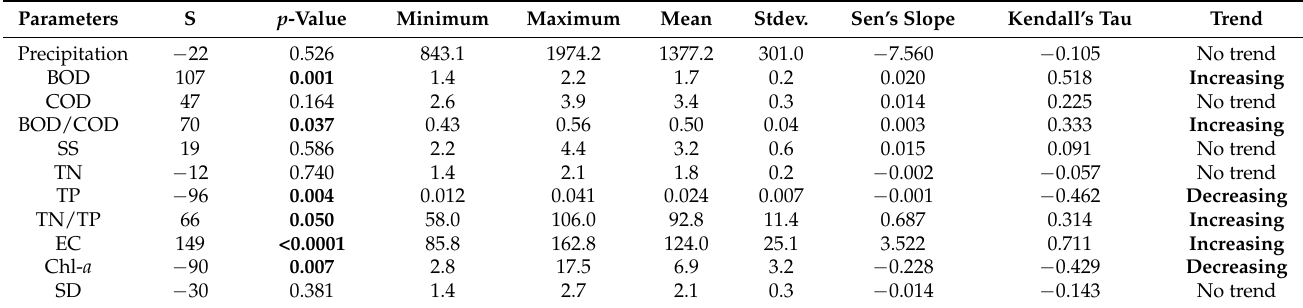
Table 1. Statistical data of water quality parameters, including the results of a long-term trend analysis based on a Mann–Kendall trend (MKT)